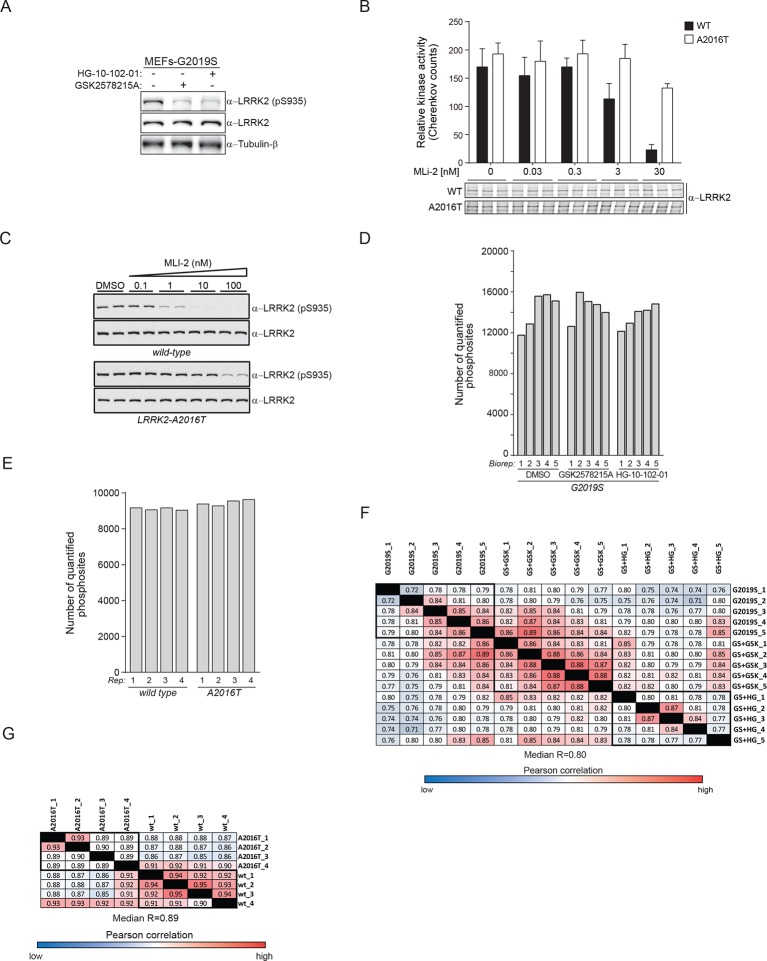
Two unbiased phosphoproteomic screens identify physiological LRRK2 targets.(A) Western blot analysis of wild type (wt) and LRRK2-G2019SGSK (G2019S) mouse embryonic fibroblasts (MEFs), treated with DMSO (-) or 1 µM of GSK2578215A or HG-10-102-01 for 90 min. (B) In vitro kinase assay using LRRK2 immunoprecipitated from MEFs (wt and A2016T) in the presence of various concentrations of MLi-2. Phosphorylation of Nictide was quantified by liquid scintillation counting. The western blot below shows that similar levels of LRRK2 were used. Error bars are mean ± SD (n=3). (C) Western blot analysis of pS935-LRRK2 and total LRRK2 levels in wt-LRRK2 MEFs and A2016T-LRRK2 MEFs treated for 60 min with the indicated concentrations of MLI-2. (D) Number of quantified class I phosphorylation sites of PS1 in five biological replicates (Biorep) per phenotype analyzed. (E) More than 9000 phosphorylation sites are identified in each of the four biological replicates (Biorep) of wild type and A2016T MEFs (PS2). (F) Pearson correlations for the phosphoproteomes of PS1 and PS2 (G). SD, standard deviation.